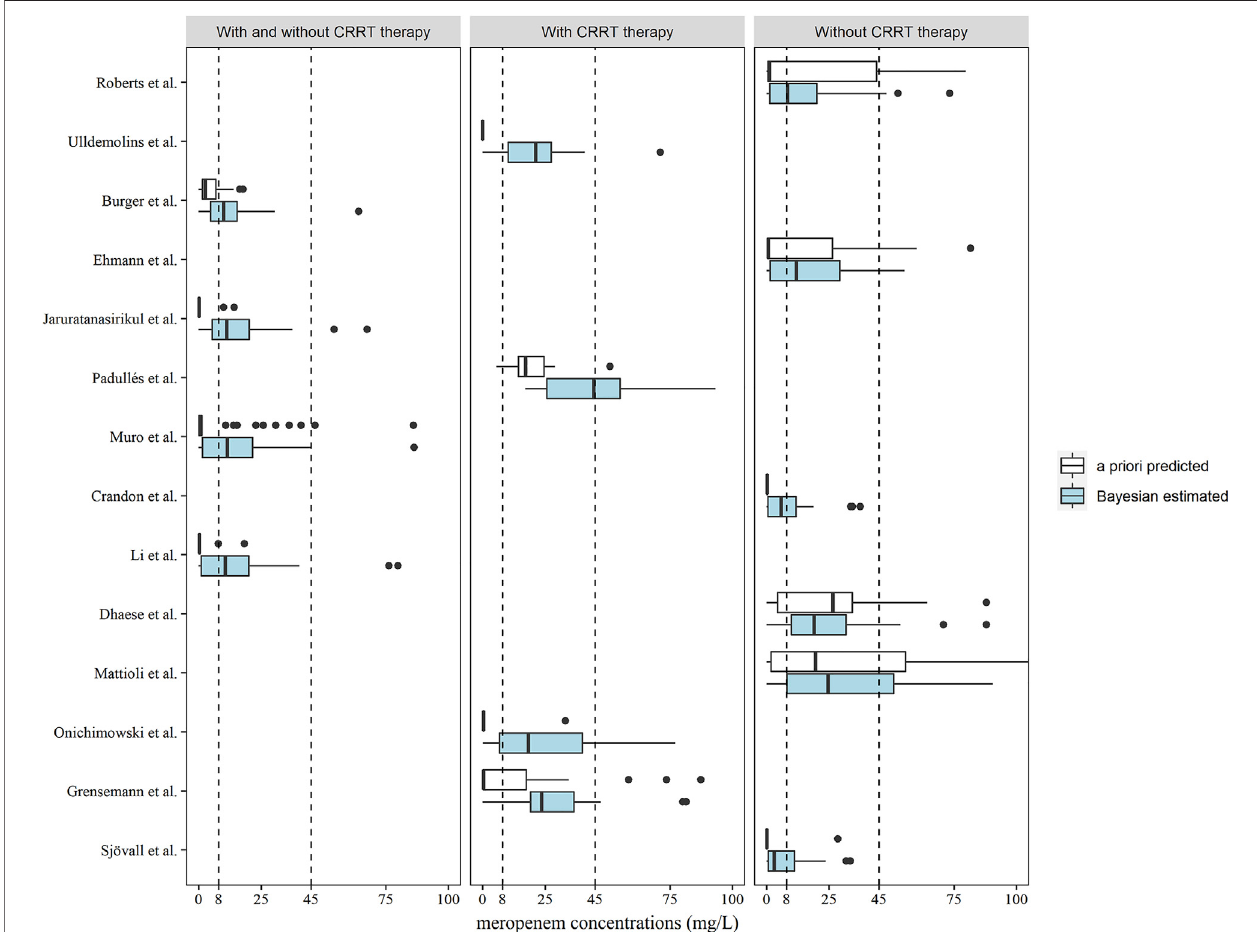
FIGURE 4 | Box plots of predicted meropenem trough concentrations after a priori predicted (white) and Bayesian estimated (blue) methods (n = 46). Box plots represent the 25th, 50th, and 75th percentiles, and the outliers are marked as dots. The area enclosed by the black dotted line indicates the target meropenem concentration range of 8 – 45